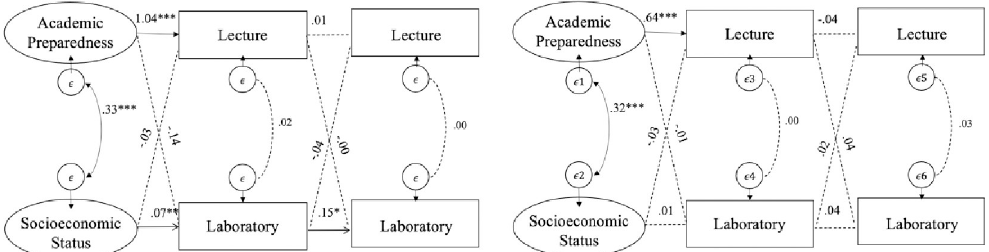
Fig 3. Multi-group structural equation model representing the associations between lecture and inquiry-based lab performance in chemistry course series. left: LM students, right: non-LM students; latent covariates for academic preparedness and SES are included but not shown; dashed lines describe non-significant path estimate; � p < .05., �� p < .01., ��� p < .001.